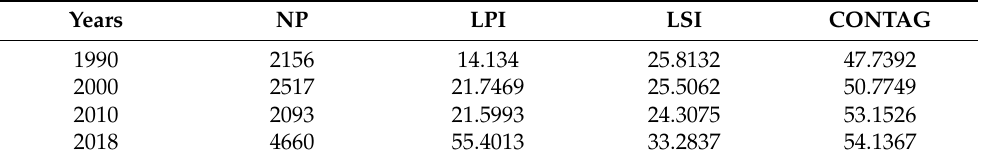
Table 10. Landscape metrics in landscape level in 1990, 2000, 2010 and